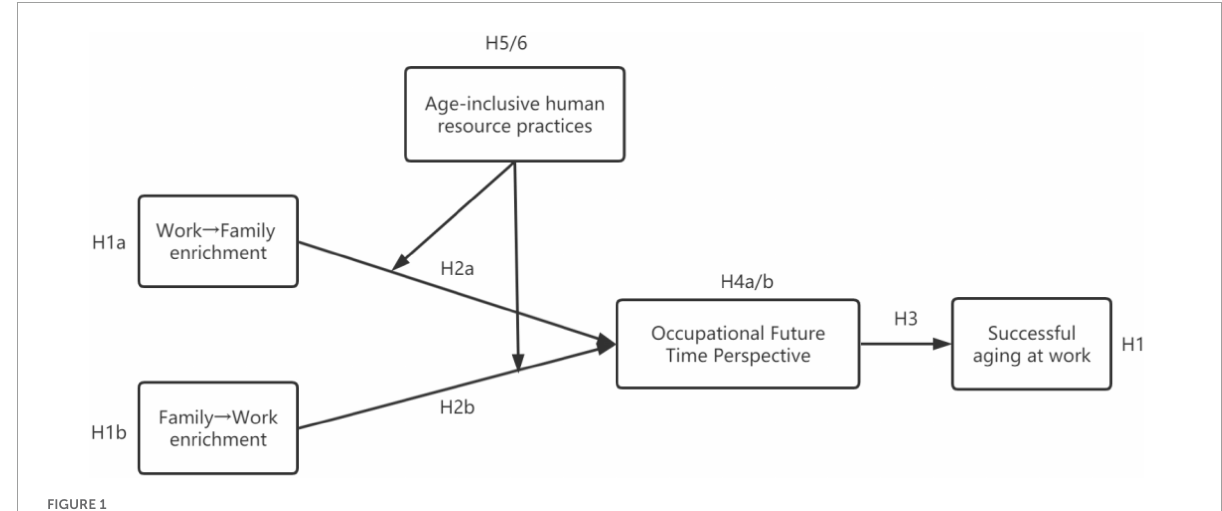
FIGURE1 Conceptual model.